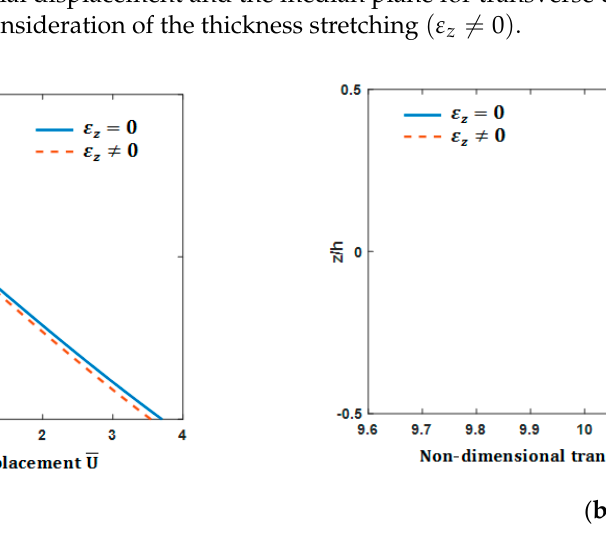
Figure 7. Non-dimensional: ( a ) axial displacement ,𝑈 and ( b ) mid-span deflection 𝑊 through the FG beam thickness.